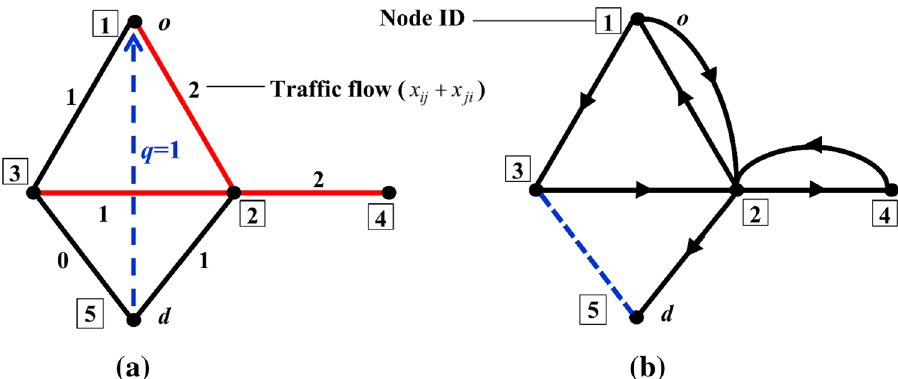
Fig. 6 A simple example: a footprints of the city bus (traffic flows) based on the minimum cost network flow on an undirected network (the red colored links represent places of interest and must be visited at least once); b the corresponding augmented directed network to show how the city bus navigates through